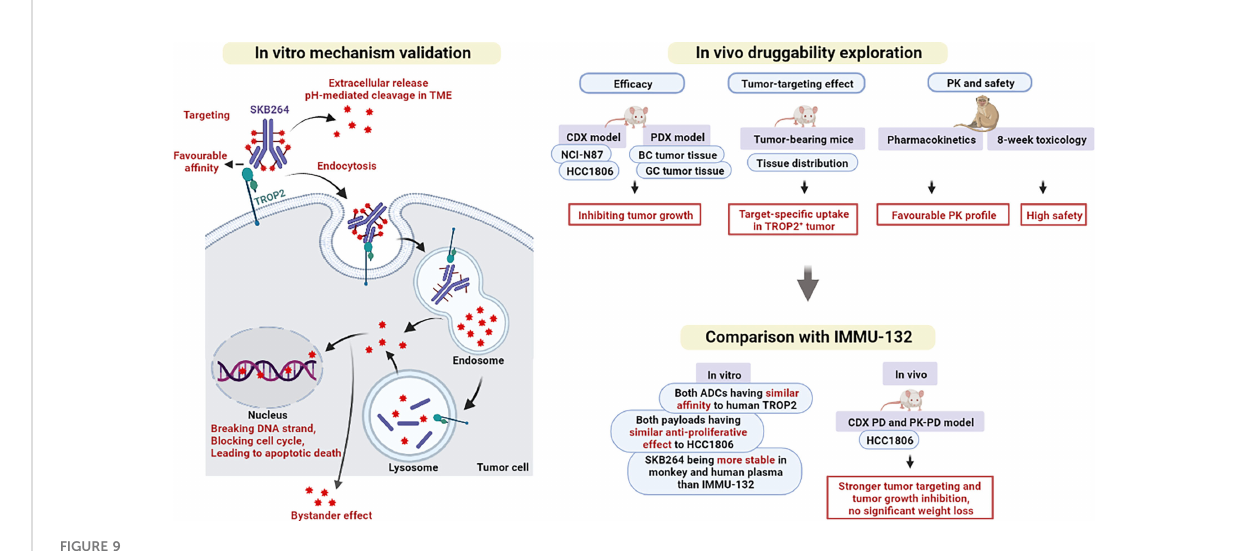
FIGURE 9 Graphical summary of the main fi ndings in this